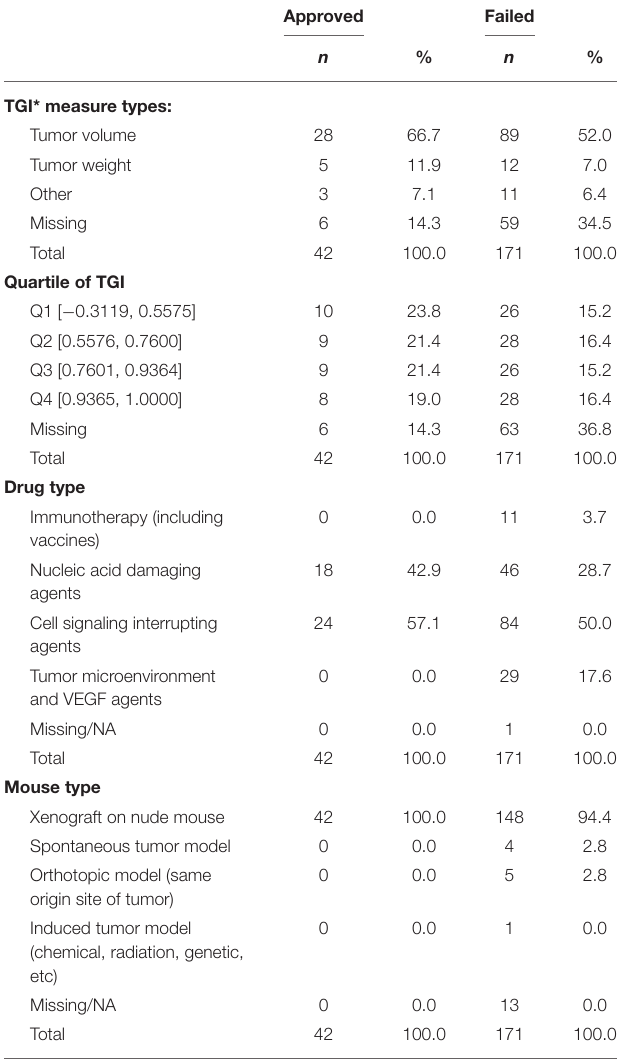
TABLE 2 | Distributions of preclinical animal study data ( n =